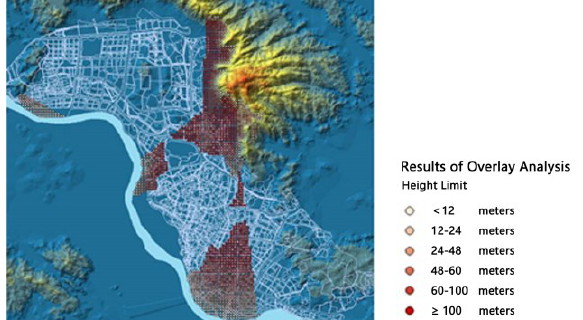
Figure 8. Results of overlay analysis of visual corridors (Wang Tong, Jiang Ying, Luo Wen, 2016)